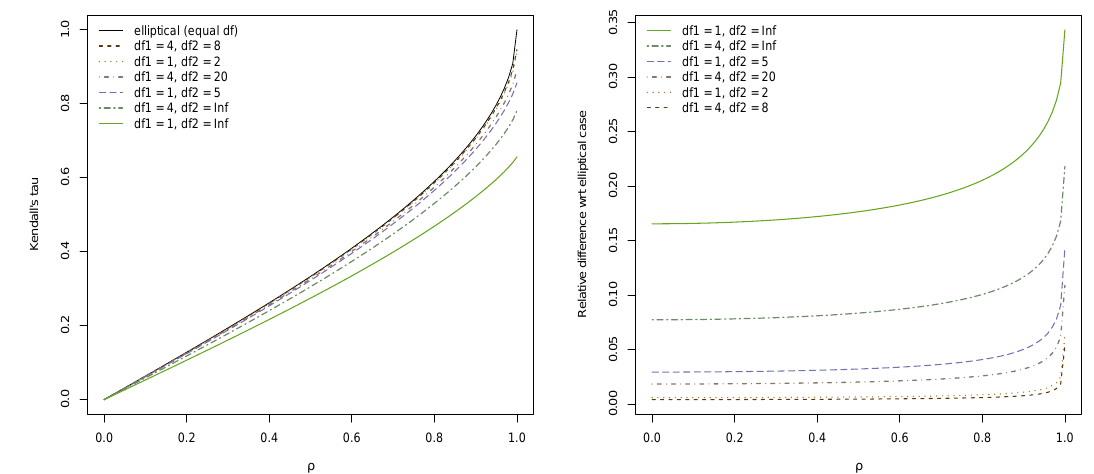
Figure 4. Kendall’s tau for a bivariate grouped t distribution for various ρ estimated via corgnvmix() ( left ); relative difference of ρ τ wrt the elliptical case ( right